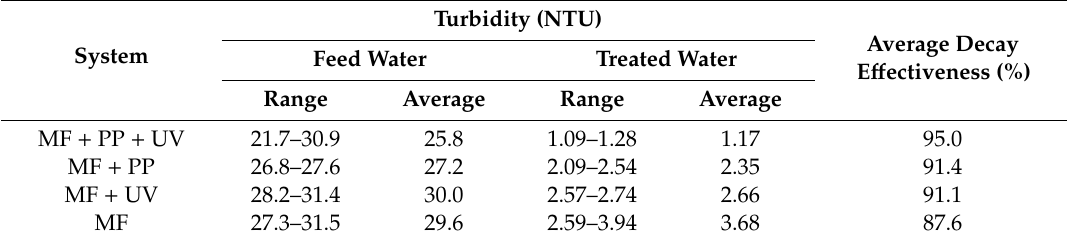
Table 3. Decay e ff ectiveness of turbidity for the function of microfiltration, adsorption, and photo- oxidation at humic acid 6 mg / L in the integrated system, of multichannel ceramic MF and pure PP particles, using air backwashing.